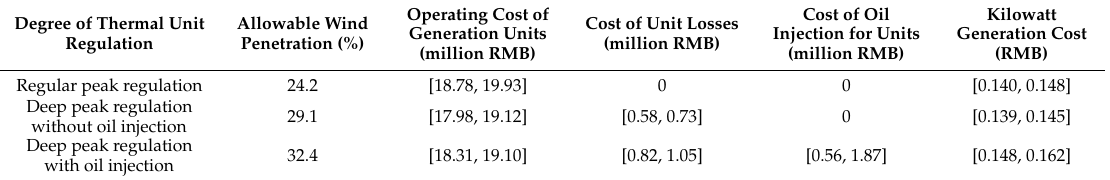
Table 7. Computation results based on distributed integration of wind